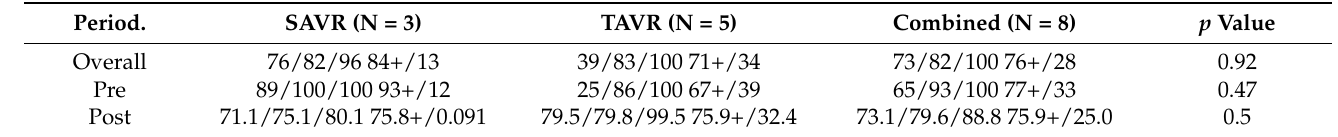
Table 3. Compliance on the use of the device according to the procedure, SAVR vs. TAVR. Data are reported as I quartile, median and III quartile, median and standard deviations. Period.